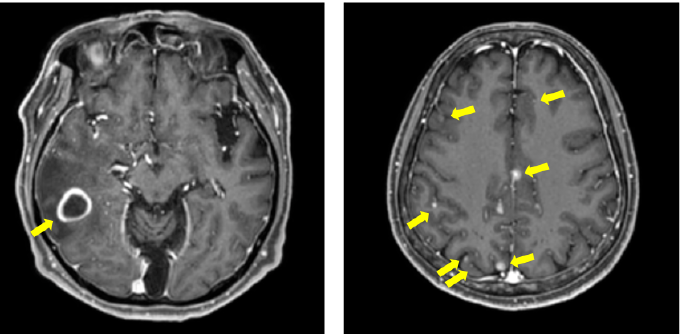
Figure 1. Examples of T1Gd images with BM. The ( left ) image shows the randomly selected samples of large-volume BM. The ( right ) image shows the randomly selected samples of small-volume BM with multiple metastases. In each images, yellow arrows indicate the